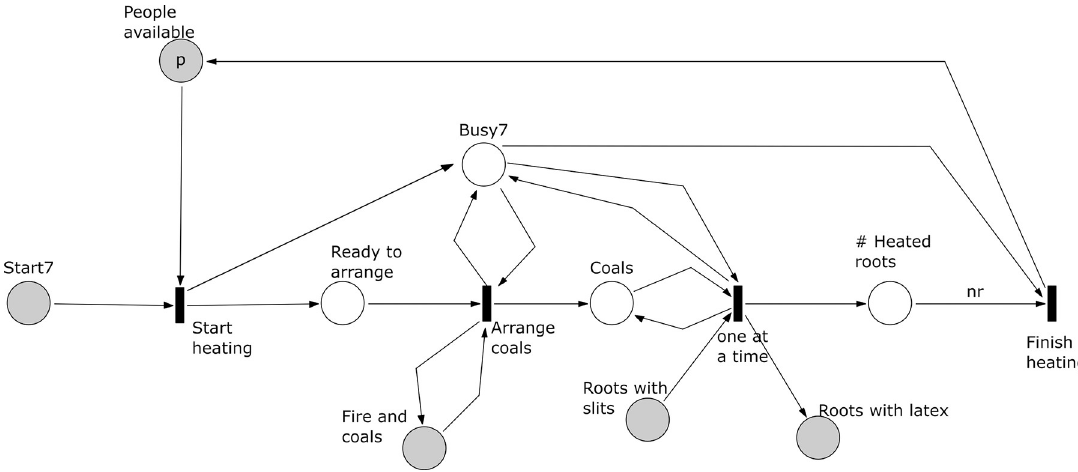
Fig 18. Subprocess 7 Heat Roots of the O . Schinzii